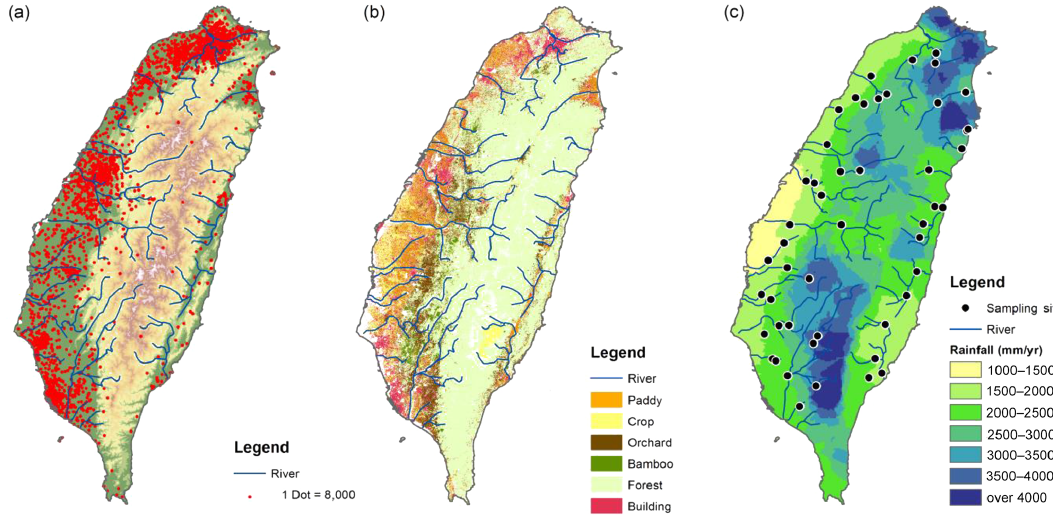
Figure 1. Three maps of Taiwan to show the population density (a) , land cover (b) , and mean annual rainfall (c) . The annual rainfall data set is provided by the water resources agency for 2002–2012. The population data set is derived from a county census from the Ministry of the Interior. The land cover data set was distributed by the Ministry of the Interior in